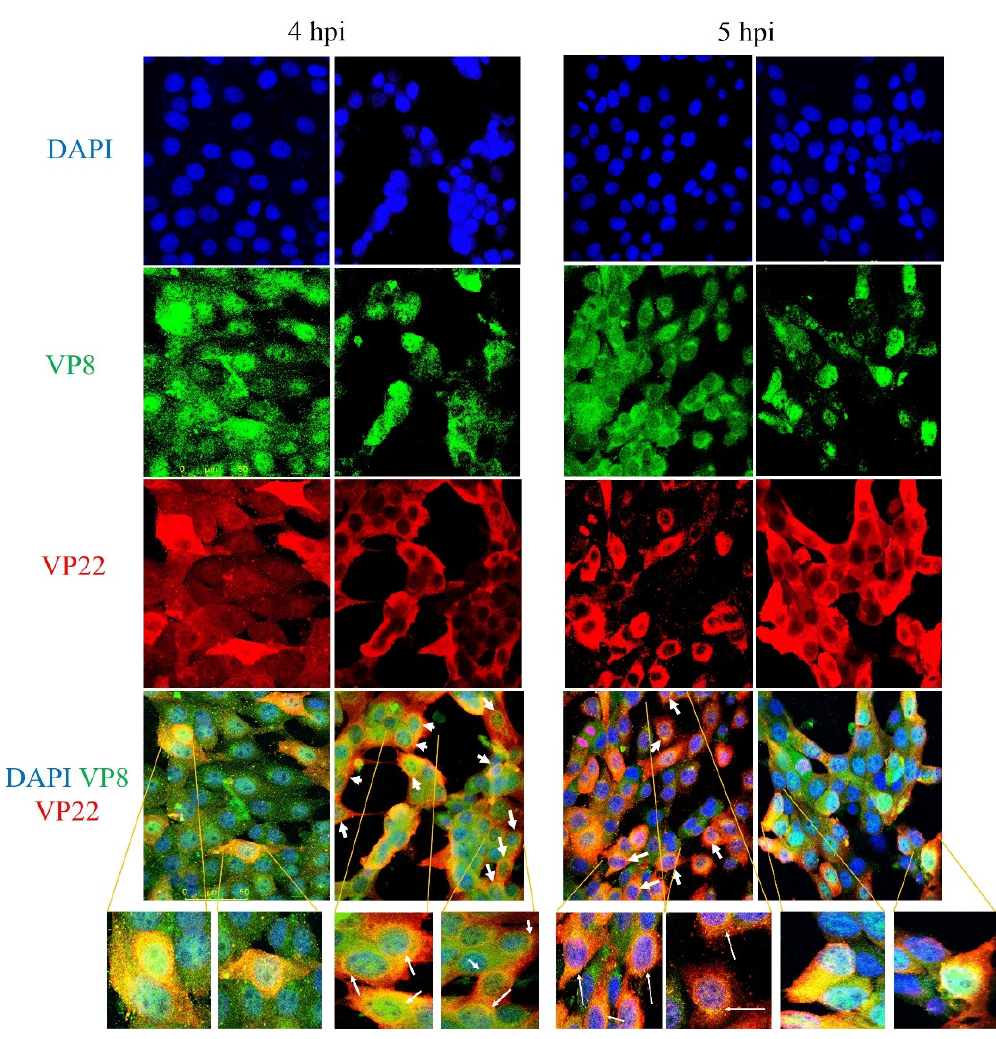
Figure 10. Co-localisation of VP22 and VP8. MDBK cells were infected with wild-type BoHV-1, and fixed and permeabilized 4 or 5 h post-infection. VP8 was identified with monoclonal VP8-specific antibody and Alexa 488-conjugated goat anti-mouse IgG. VP22 was detected with rabbit VP22-specific antibody and Alexa 633-conjugated anti-rabbit IgG. The yellow ring (as indicated by the arrows) shows co-localisation of VP8 and VP22 proteins in the perinuclear region. Select cells were observed at 10 × magnification to show more details.